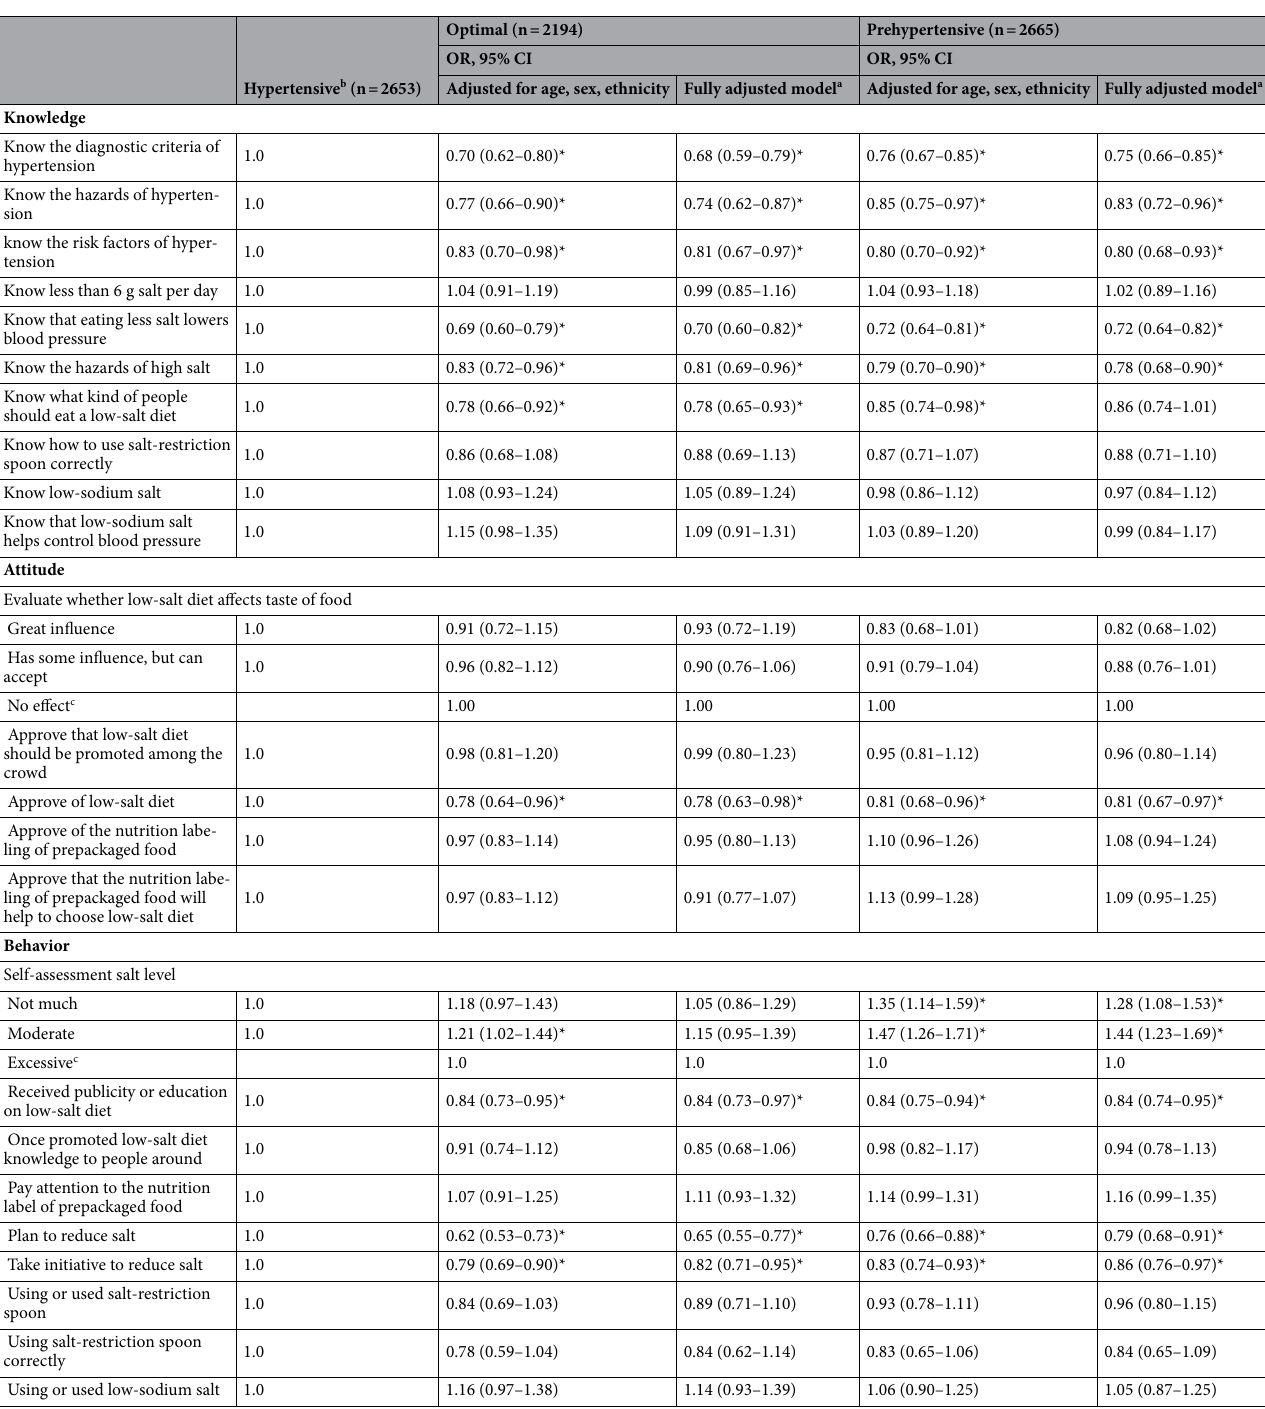
Table 5. Association (adjusted odds ratio and 95%CI) between various KAB exposures studied with hypertensive status among Zhejiang residents, SRHPP 2017–2018. CI confidence interval, OR odds ratio. a Fully adjusted models included age, sex, ethnicity, education, body mass index, history of cardiovascular disease, diabetes status, chronic kidney disease, smoking status, alcohol use status and physical activity. b With hypertensive as a reference. c With this row as a reference. * P <